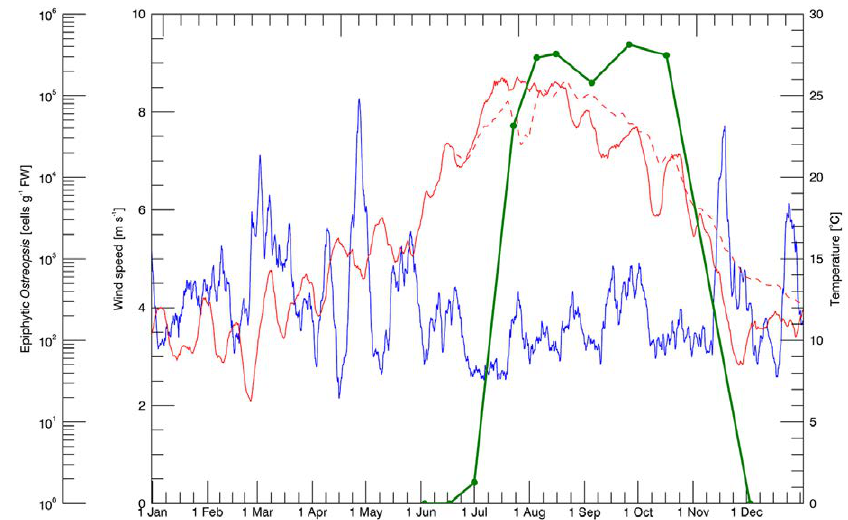
Fig. 1. – Temporal evolution of wind intensity (blue line), air temperature (solid red line) and water temperature (dashed red line) along with the epiphytic concentrations of Ostreopsis cf. ovata (green line) in 2013. The data of the three environmental parameters were low-pass filtered using a cut off period of 7 days (running